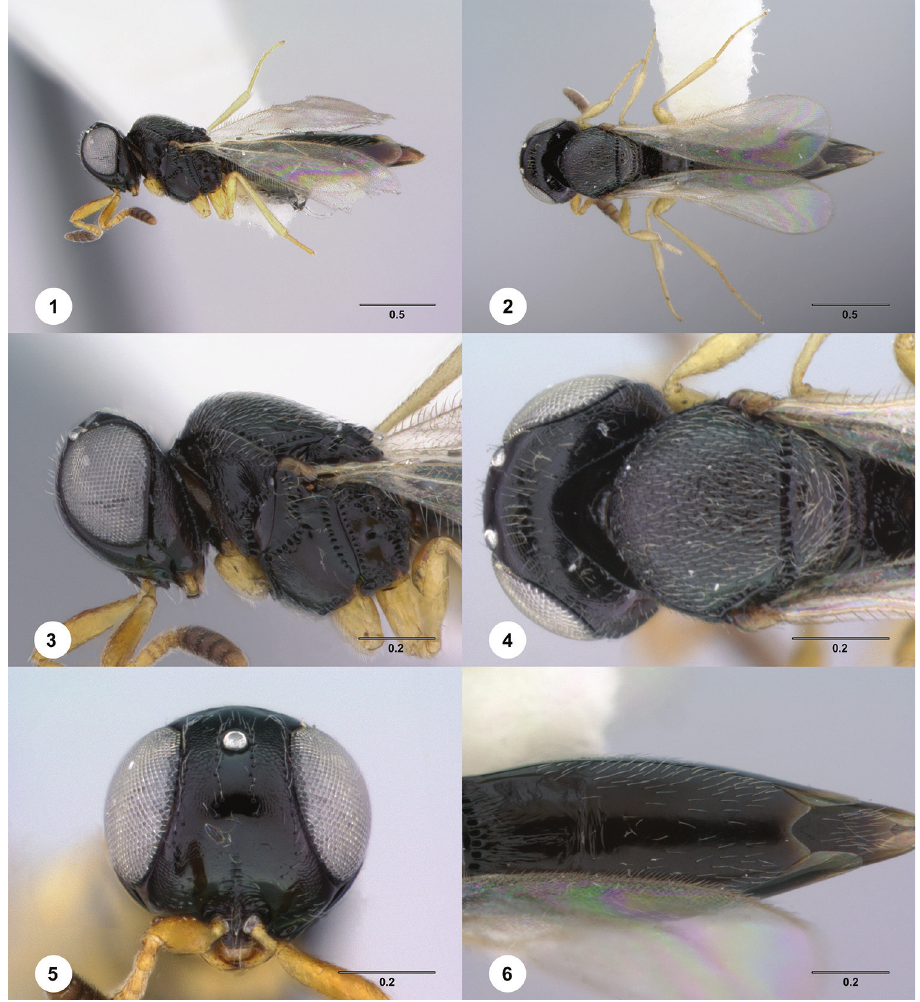
mesosoma, lateral view 4 Head, mesosoma, dorsal view 5 Head, mouthparts, anteroventral view 6 T2–T4, dorsal view. Scale bar in